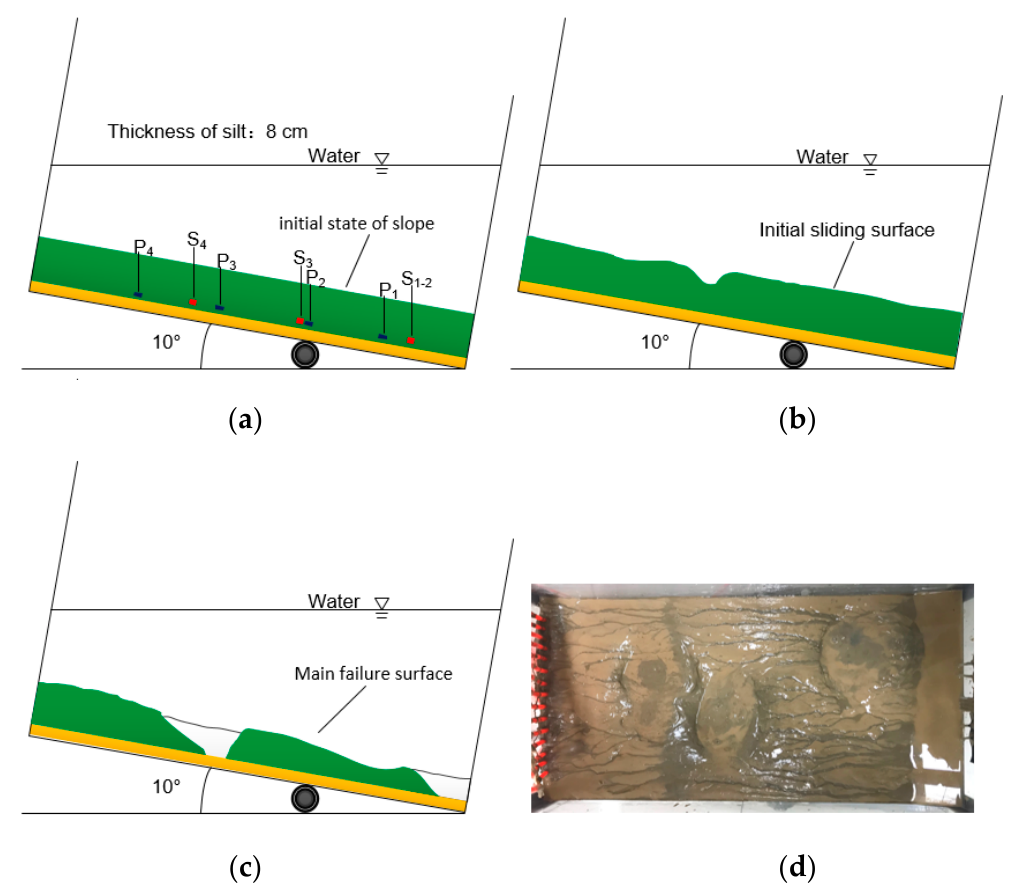
Figure 14. Profile and plan views of the slope after failure in Model 8-10. ( a ) Before Angle adjustment; ( b ) After the Angle adjustment; ( c ) After the destruction; ( d ) top view of end of experiment.